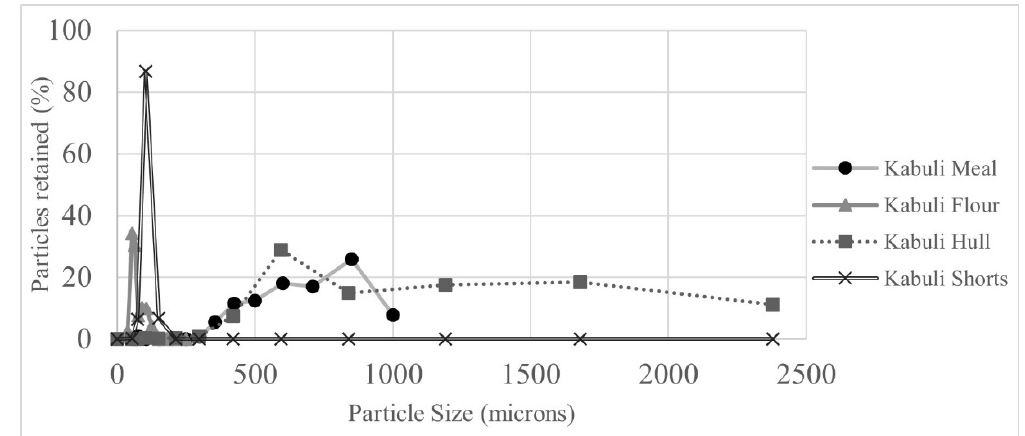
Figure 3. Particle Size of Process 1, (Kabuli) Milling Streams .